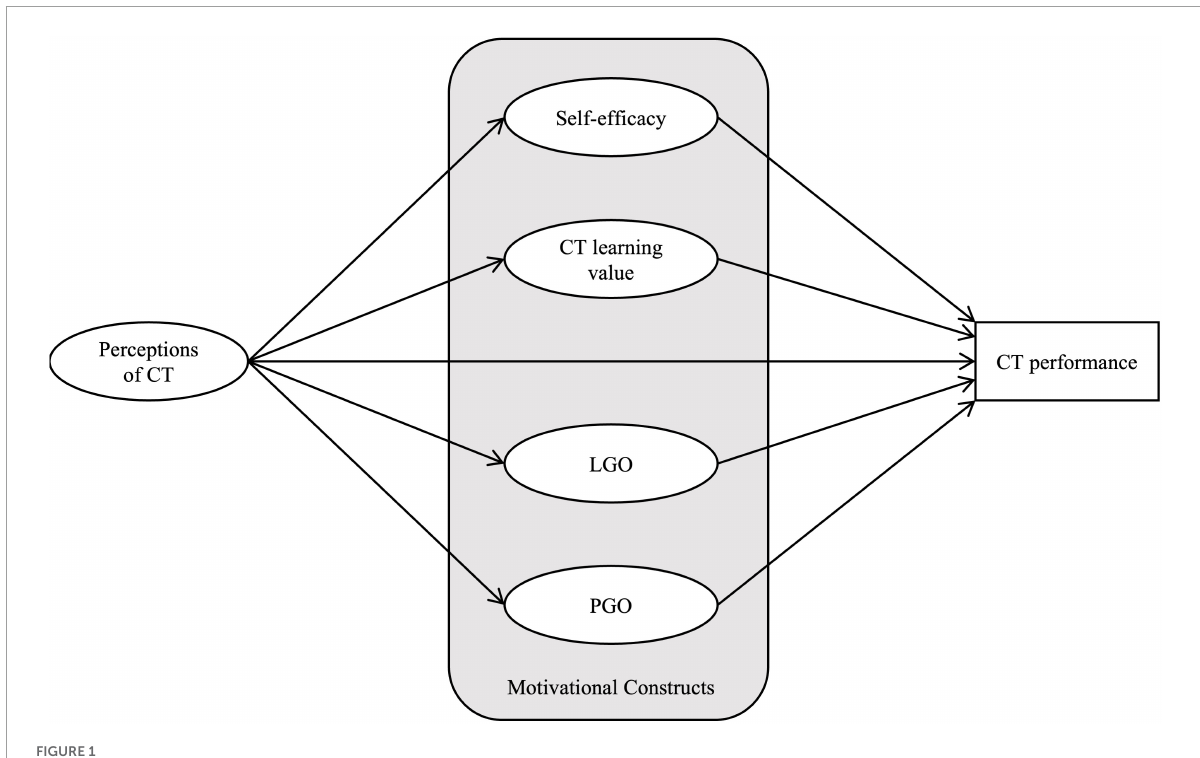
FIGURE1 Hypothesized structural